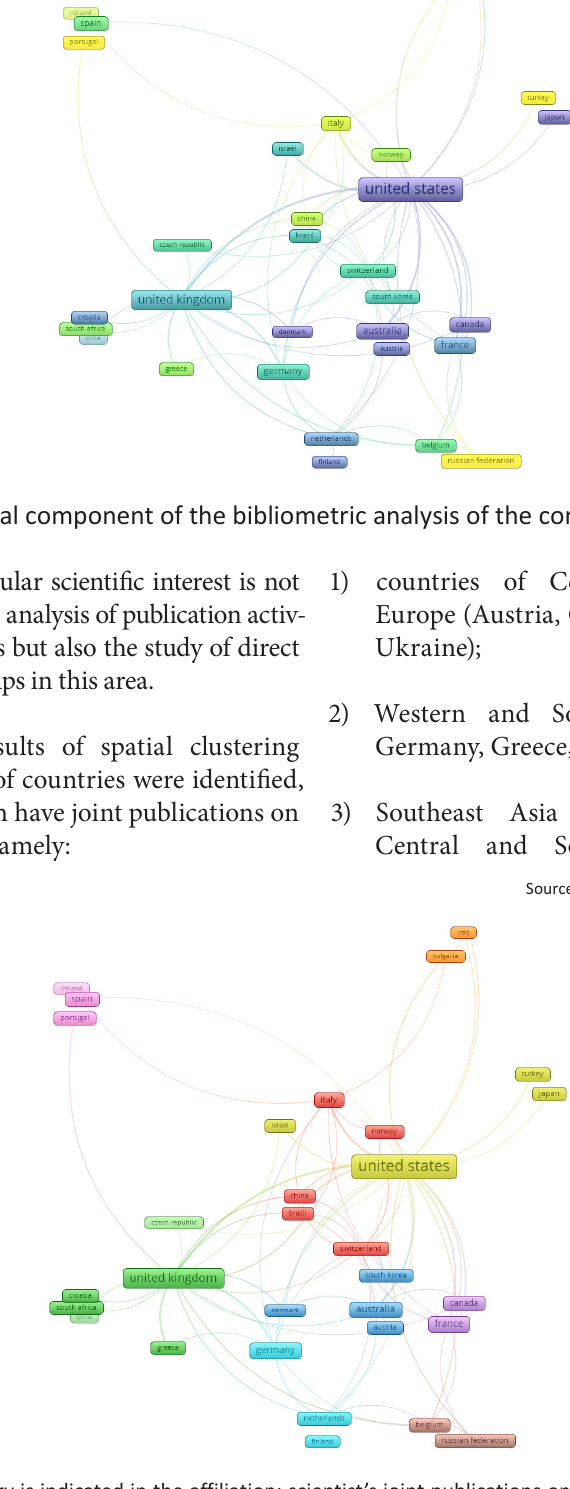
Figure 8. Visualization map of the